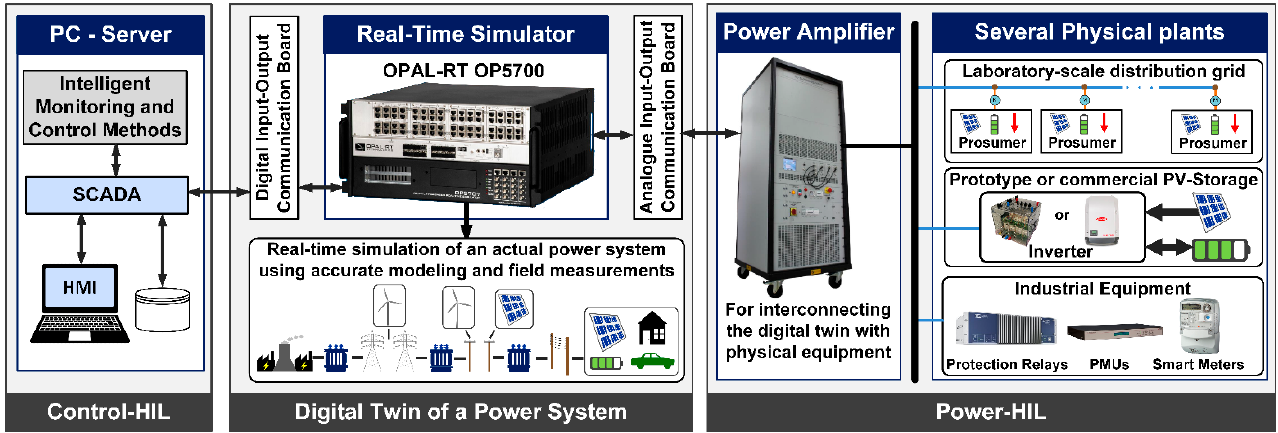
Figure 6. General architecture of the smart grid layer in an RT-HIL environment.